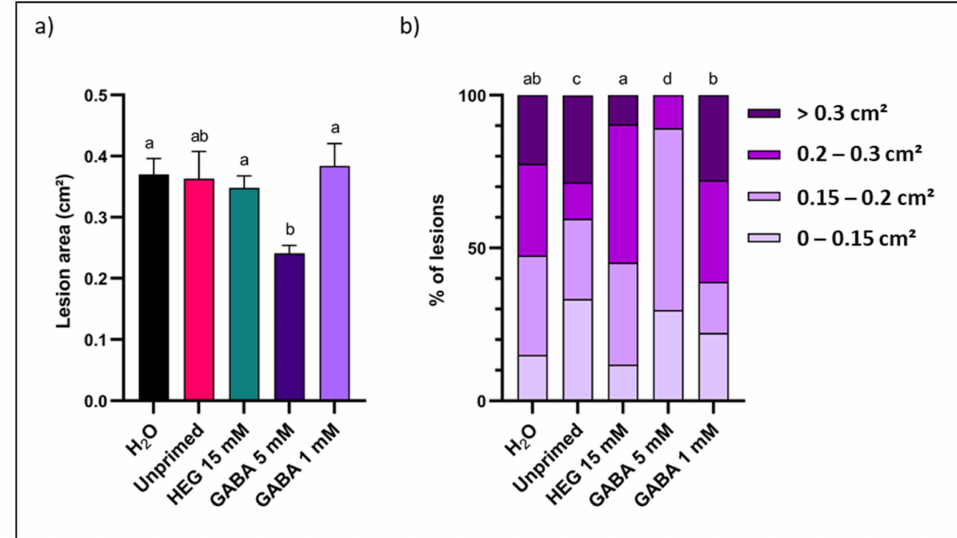
Figure 1. Validation of the priming-infection assay in the rocket- Botrytis cinerea pathosystem. After 72 h of priming, leaves were detached, rinsed and inoculated with B. cinerea spores. Infection progressed for 72 h before disease scoring. ( a ) Average lesion area of negative, osmotic (hexaethylene glycol, HEG) and positive control ( γ -aminobutyric acid, GABA). Bars represent the mean ± SEM. ( b ) Percentage of lesions belonging to each of four different classes based on lesion size. A minimum of 30 biological replicates were used per treatment and the experiment was repeated three times with consistent results. Letters indicate significant differences between treatments ( p <